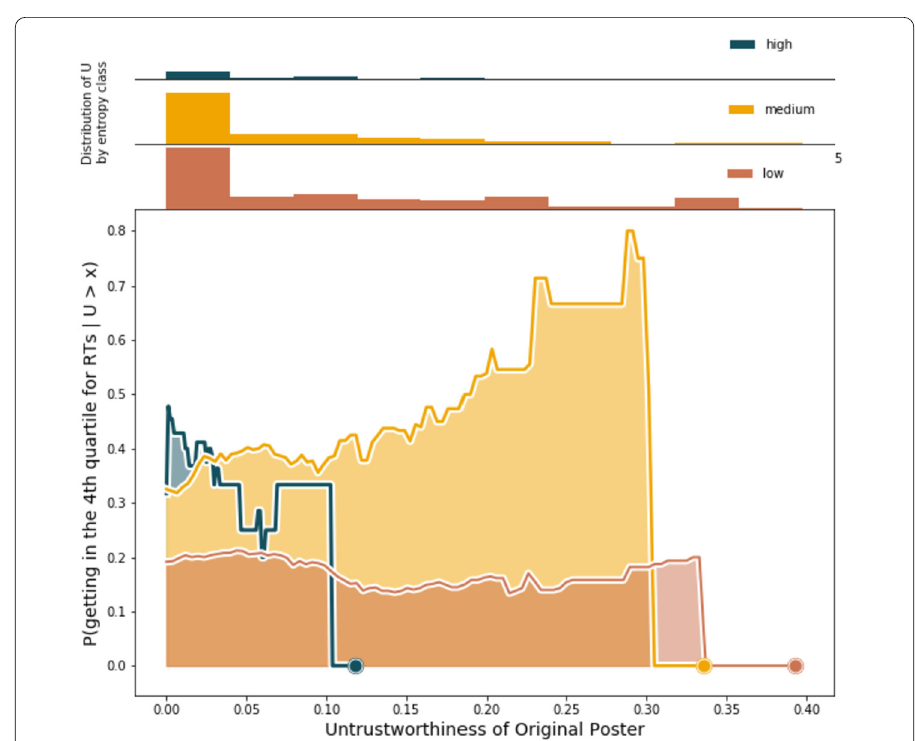
Figure 7 Probability of success of a tweet given the Untrustworthiness of the OP. As seen in Fig. 6 for the BotScore, medium entropy URLs tend to dominate over the others, almost always obtaining more success. The only exception being the high entropy and low- U URLs that probably represent a core of reliable, mainstream media content that are widely diffused through the network. Evidence in this Fig. and in Fig. 6 suggests that the key for a URL to be successful is to be diffused beyond its originating community, but without getting too far from it, or better yet, without being shared in too many other